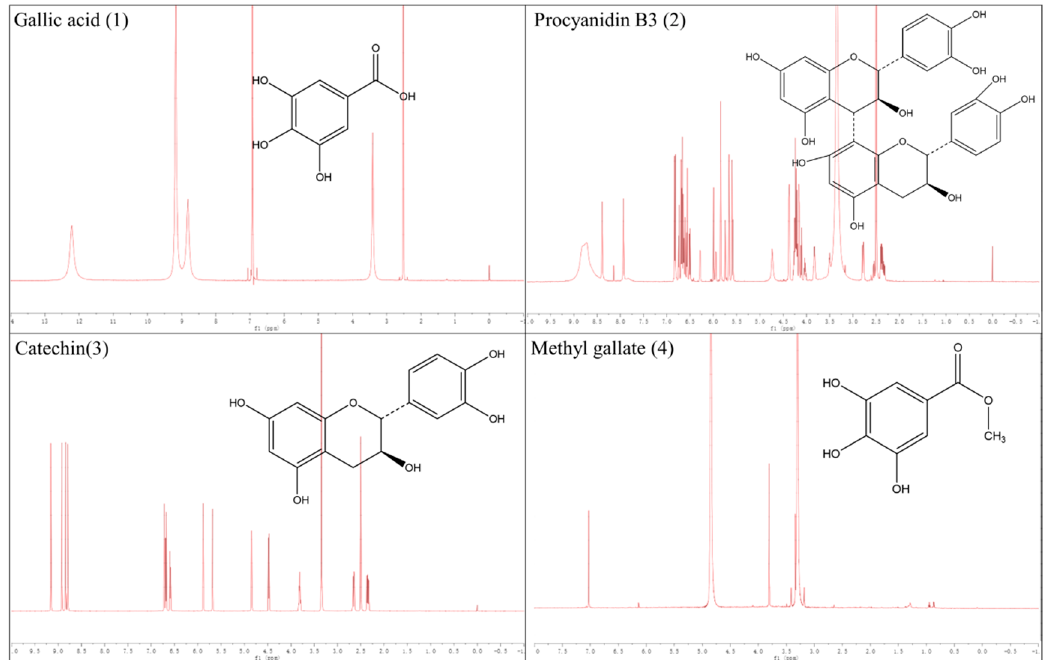
Figure 4. 1 H NMR spectra and chemical structures of target compounds isolated from the ethyl acetate fraction of the evening primrose seeds 50% ( v / v ) methanol extract (EME).